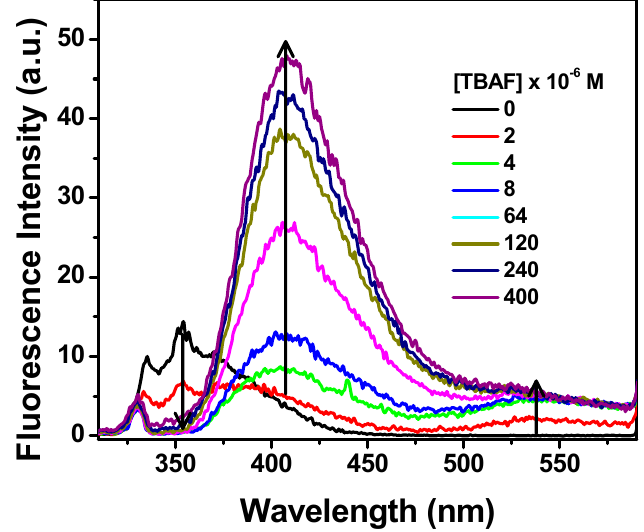
Figure 10. Fluorescence spectra of NpTP (~1 × 10 − 6 M) upon the addition of TBAF in acetonitrile. Concentrations of TBAF are provided on the legends. λ exc = 300 nm.